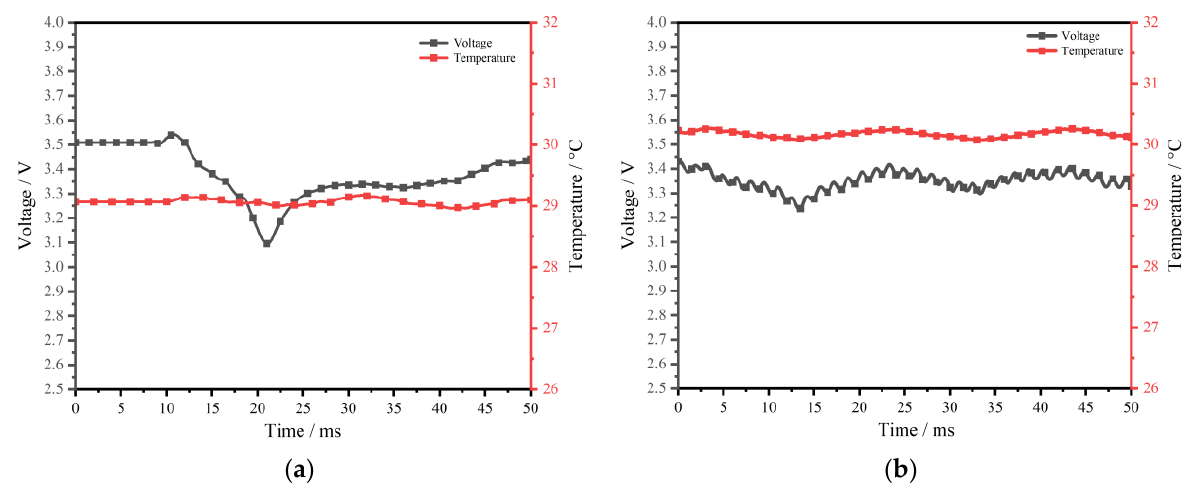
Figure 6. Voltage–temperature–time curve of the battery in both Z+ orientations. ( a ) Test results for Z1+ orientation; ( b ) Test results for Z2+